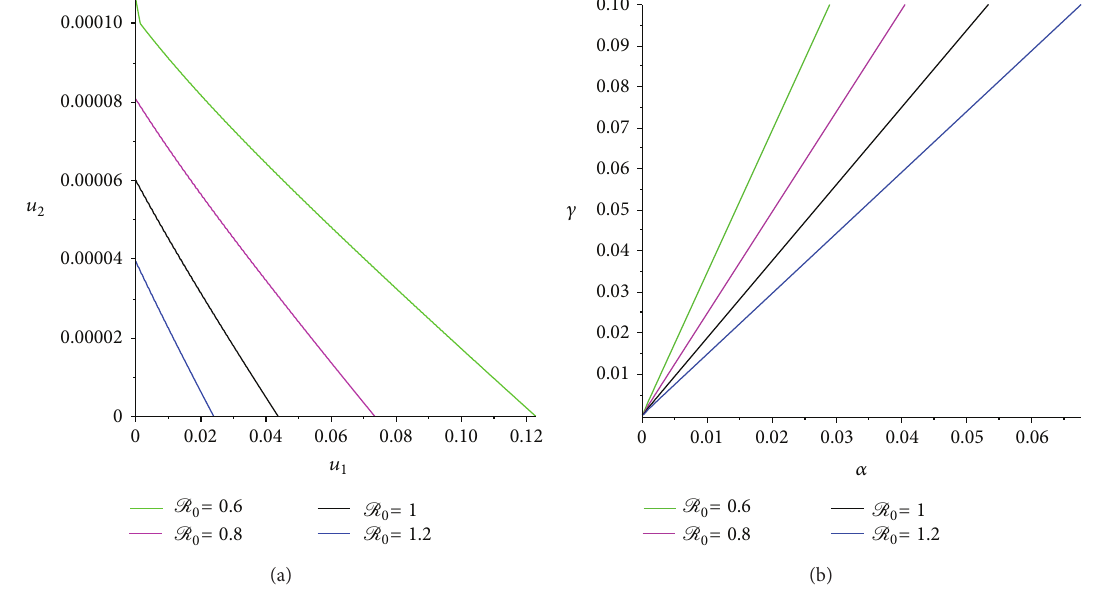
Figure 2: Parameter sensitivity of R 0 between 𝑢 1 versus 𝑢 2 (a) and 𝛼 versus 𝛾